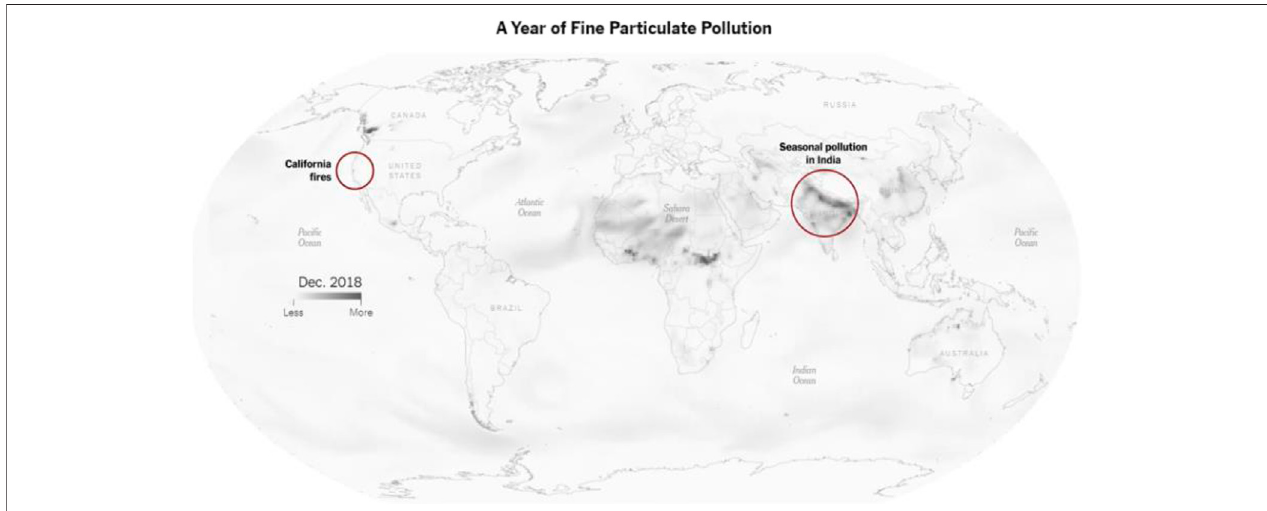
FIGURE 5 | Screen capture of the Data Journalism Award (2019) Best visualization (large newsrooms). Winner: See How the World ’ s Most Polluted Air Compares with Your City ’ s. Organization: The New York Times.